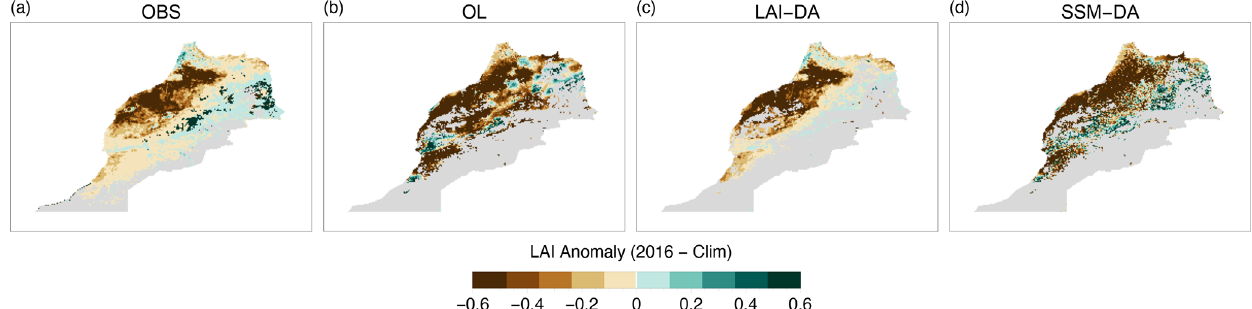
Figure 10. LAI anomaly under a drought event (2016 February) with respect to climatology of February within a SMAP period (2015–2019) for (a) a MODIS observation, (b) OL, (c) LAI-DA, and (d)